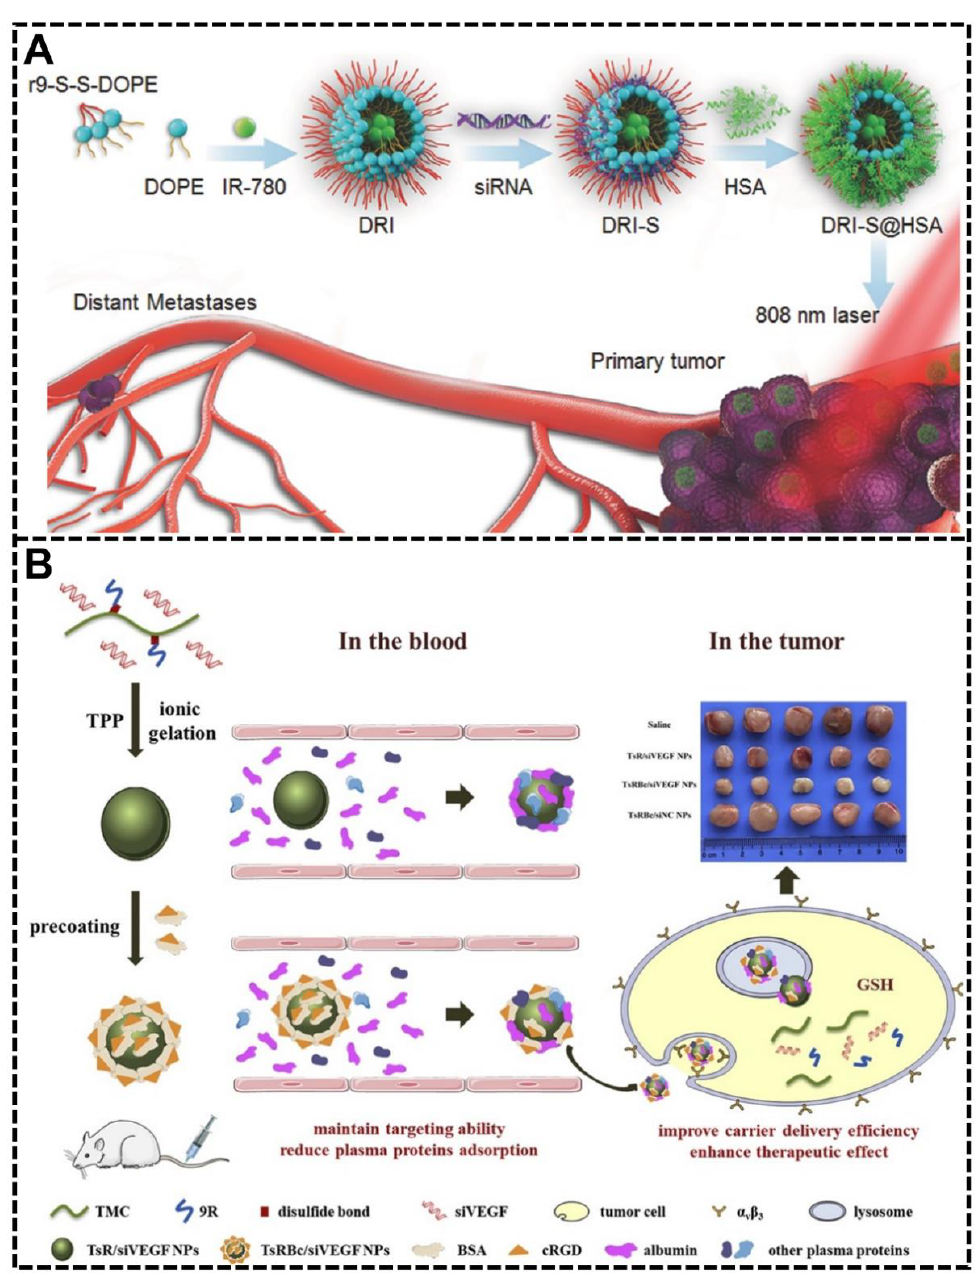
Figure 8. Endogenous protein coating for targeting effect. ( A ) The design and schematic illustration of the NP system (DRI-S@HSA) with endogenous protein albumin coating for long blood circulation time and effective tumor-targeting capability [81]. Copyright 2017, Wiley-VCH. ( B ) A bio-inspired NP system with cyclic RGDyK peptide (cRGD) modified bovine serum albumin (BSA) precoating showed enhanced targeting ability to cancer cells and reduced serum proteins adsorption by reducing the protein corona formation [79]. Copyright 2021, Elsevier.